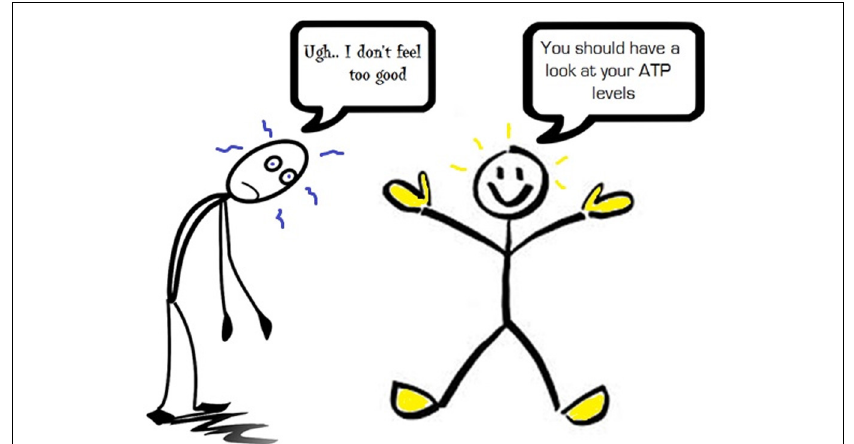
FIGURE 1 | ATP: The molecular key to good health.